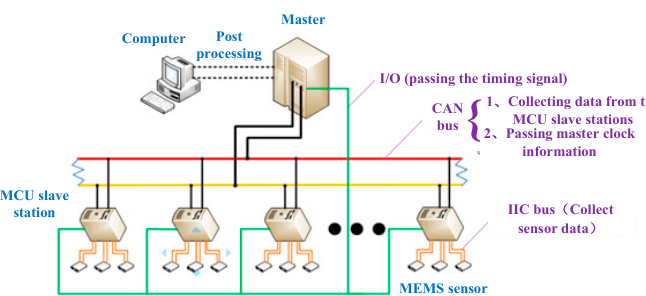
Figure 3. Two-stage data acquisition and transmission system based on the inter-integrated circuit (IIC) bus and controller area network (CAN) bus.